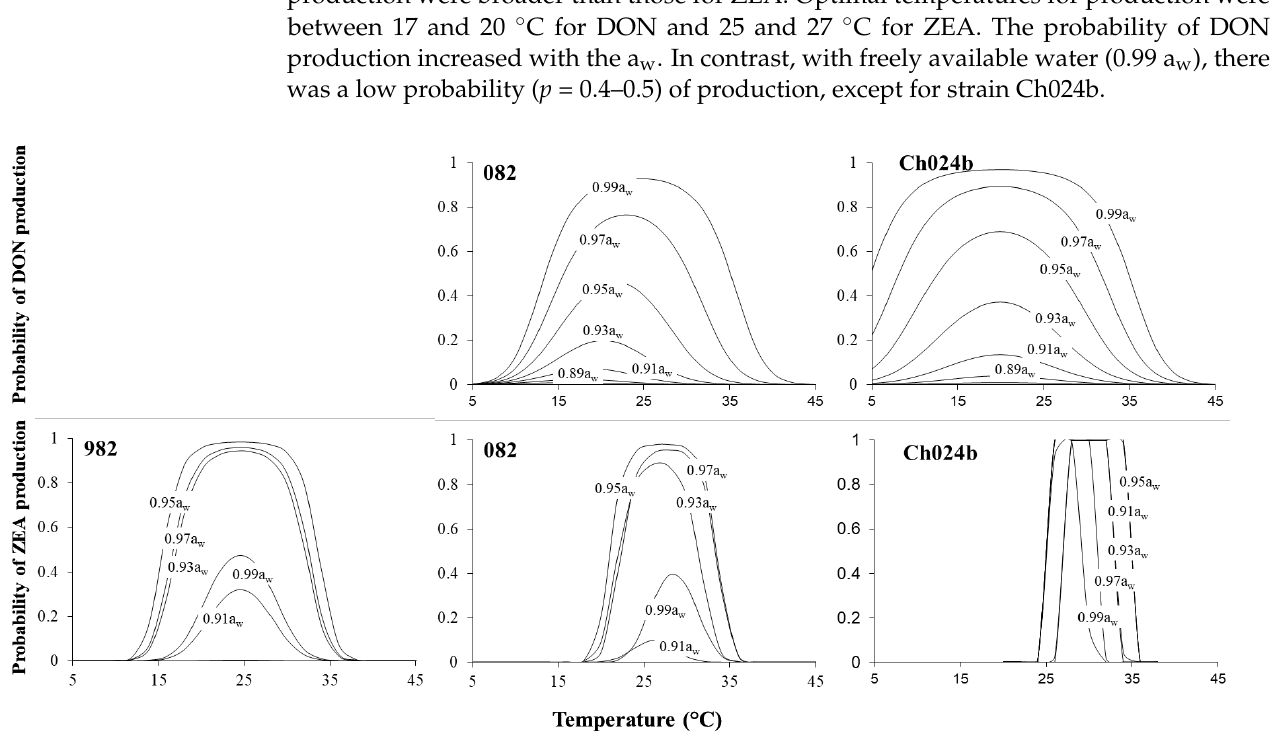
Figure 6. Estimated probability for the production of deoxynivalenol (DON) and zearalenone (ZEA) under different interacting environmental conditions by the three strains of F. asiaticum when colonizing a wheat-based medium after 10 days incubation.